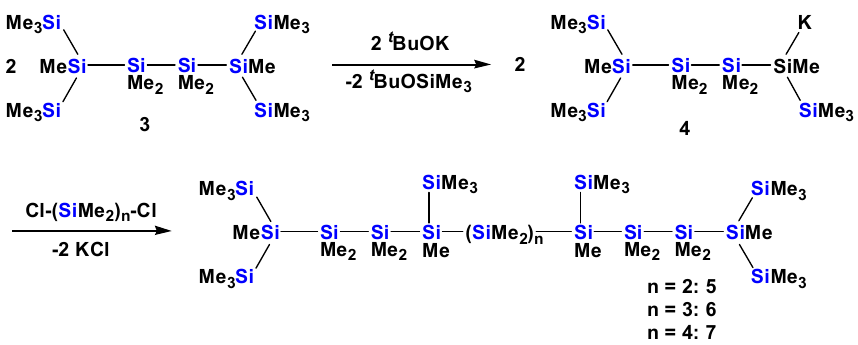
Scheme 2. Synthesis of elongated oligosilanes with trimethylsilyl substituents in the core and at the periphery of the chains.